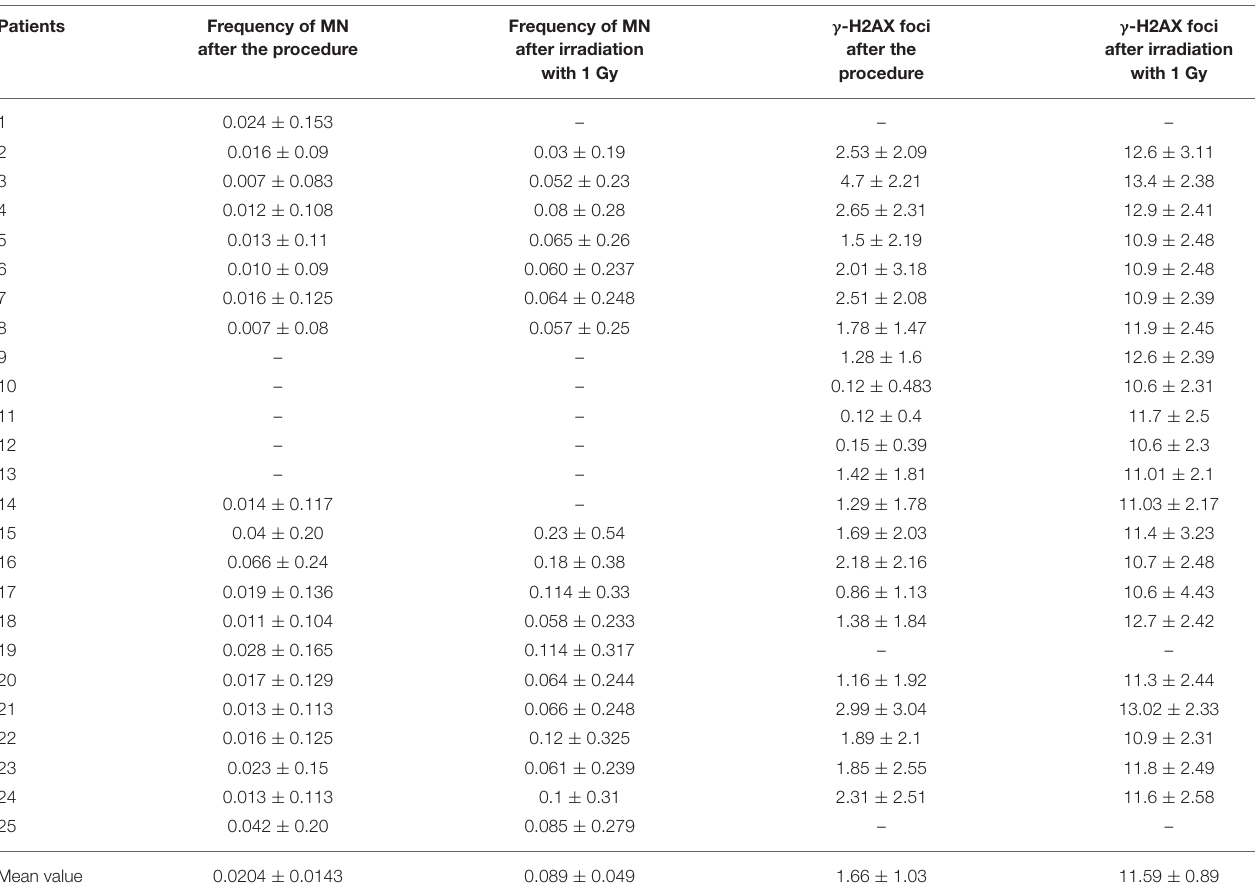
TABLE 2 | Mean values of γ -H2AX foci and frequency of Micronuclei (MN) per cell after cardiac interventional procedures ( in vivo radiation) and after irradiation with 1Gy in the laboratory ( in vitro radiation). Patients Frequency of MN after the procedure